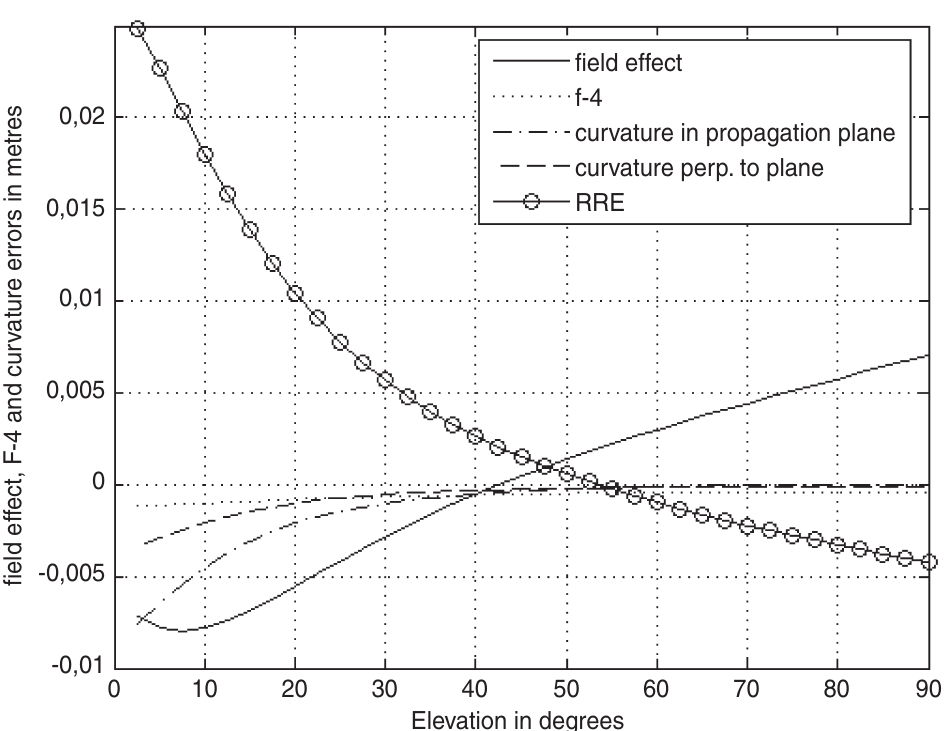
Fig. 6. Higher order errors for the GPS L1 frequency due to the f -3 and f -4 terms (including curvature terms) and the resultant RRE for dual frequency L 1/ L